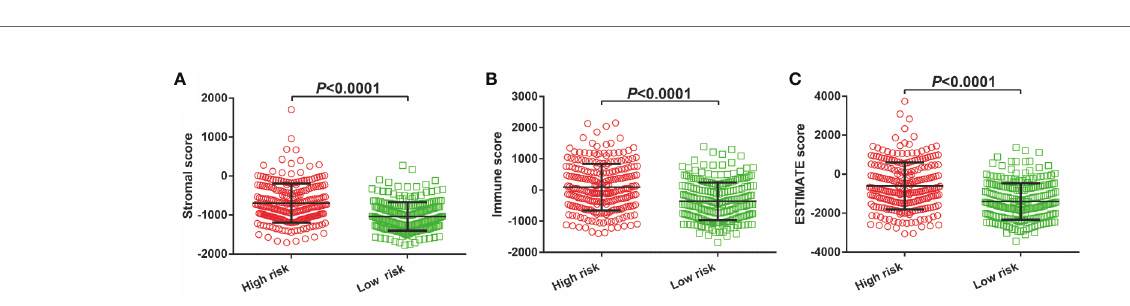
FIGURE 12 | Immune microenvironment score between high- and low-risk score phenotypes. (A) Stromal score; (B) Immune score; (C) ESTIMATE